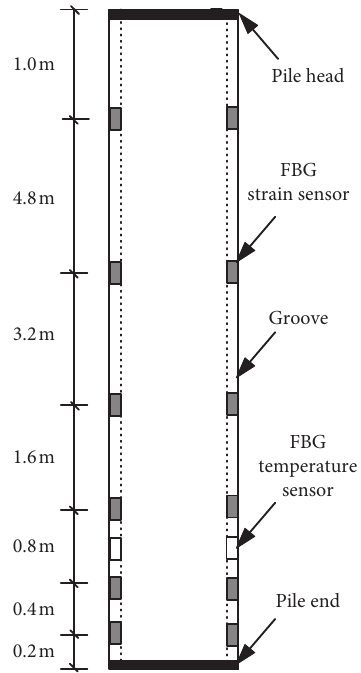
Figure 2: Installation position of the FBG sensors.